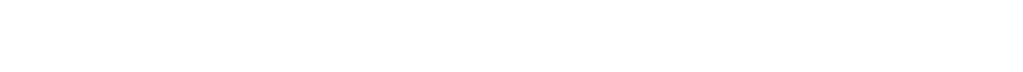
FIGURE 1 | Schematic illustration of the central role of tau oligomers in tauopathies . Figure taken from Gerson and Kayed